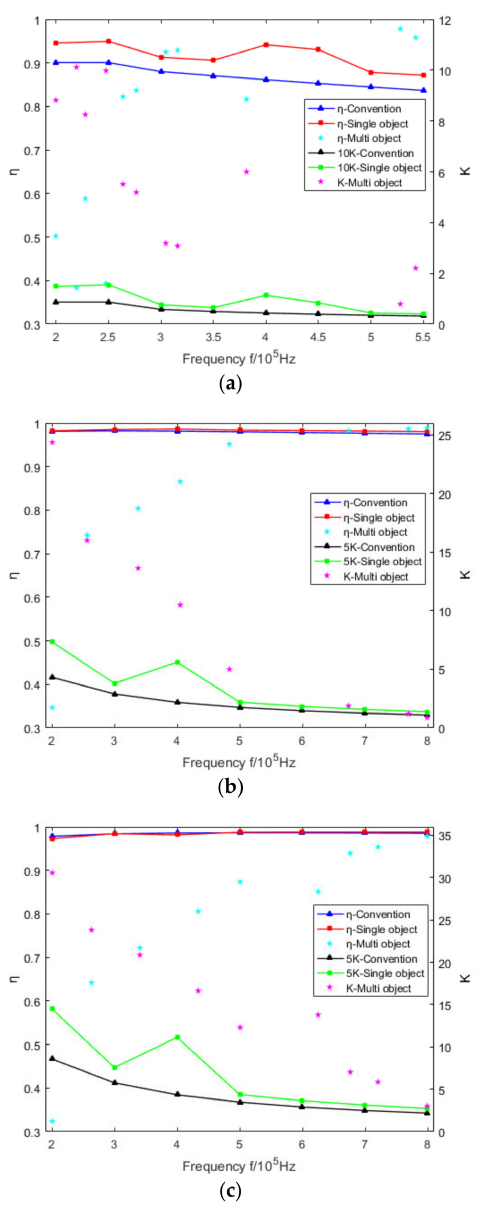
Figure 12. Efficiency η , voltage modulus gain K of traditional design, single-objective optimization, and multi-objective optimization. ( a ) The load resistance R L = 5 Ω . ( b ) The load resistance R L = 50 Ω . ( c ) The load resistance R L = 100 Ω